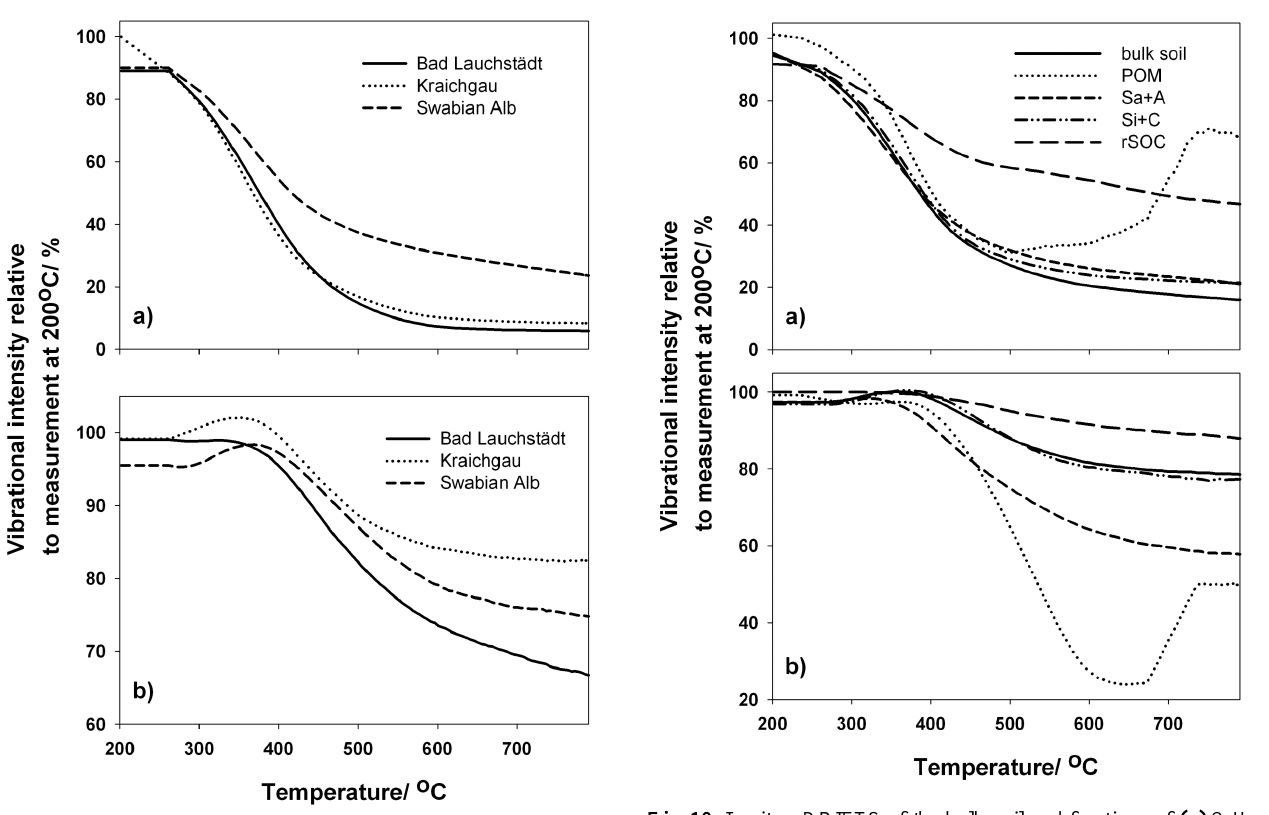
Figure 9 Fig. 9. In situ T DRIFTS of bulk soil samples from Bad Lauchst¨adt, Kraichgau, and Swabian Alb of (a) C-H (2930cm − 1 ) vibrations and (b) C = O/C = C (1620cm − 1 ) vibrations.